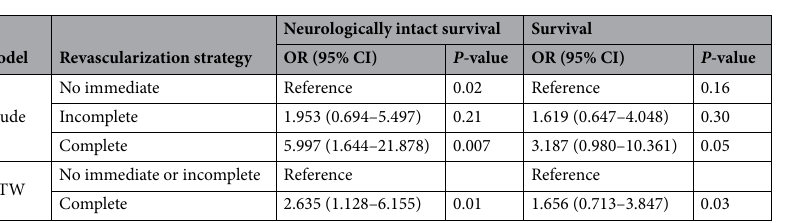
Figure 2. Neurologically intact survival and survival of patients at 1 month according to the revascularization strategies. Crude and adjusted data using the inverse probability of treatment weighting method are shown. IPTW inverse probability of treatment weighting.